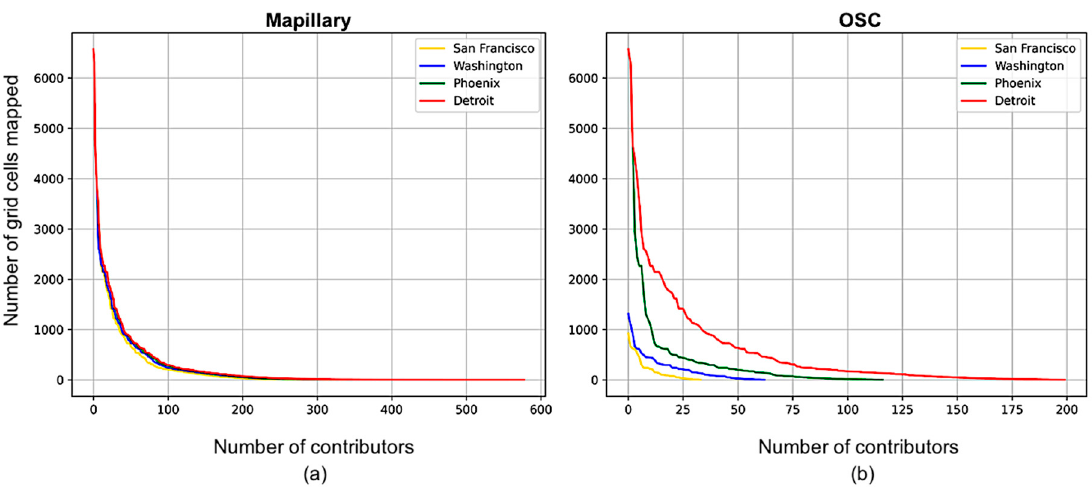
Figure 8. Number of 1 × 1 km grid cells mapped by contributors in ( a ) Mapillary and ( b ) OSC.